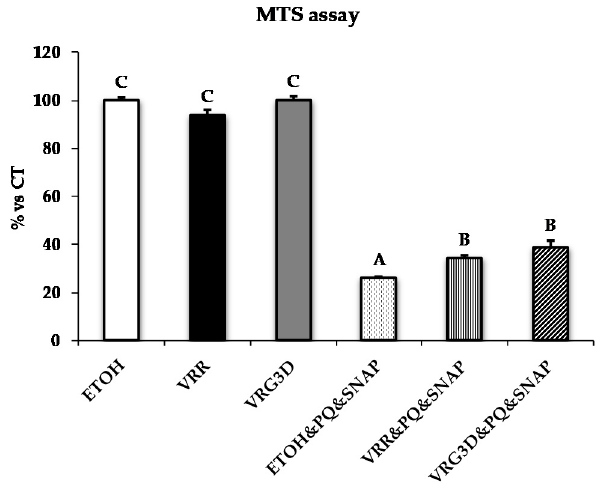
Figure 2. Effects of treatment with different mung bean extracts on metabolic status of U937 cells challenged with peroxynitrite. Results are represented as means ± SEM. Superscripts when different indicate p < 0.05. CT, control. ETOH, ethanol. VRR, raw Vigna radiata . VRG3D, 3d-germinated Vigna radiata . ETOH&PQ&SNAP, ethanol plus PQ/SNAP. VRR&PQ&SNAP, raw Vigna radiata plus PQ/SNAP. VRG3D&PQ&SNAP, 3d-germinated Vigna radiata plus PQ/SNAP. PQ, Paraquat . SNAP, S- nitroso-N-acetylpenicillamine . MTS, 3-(4,5-dimethylthiazol-2-yl)-5-(3-carboxymethoxyphenyl)-2-(4- sulfophenyl)-2H-tetrazolium .